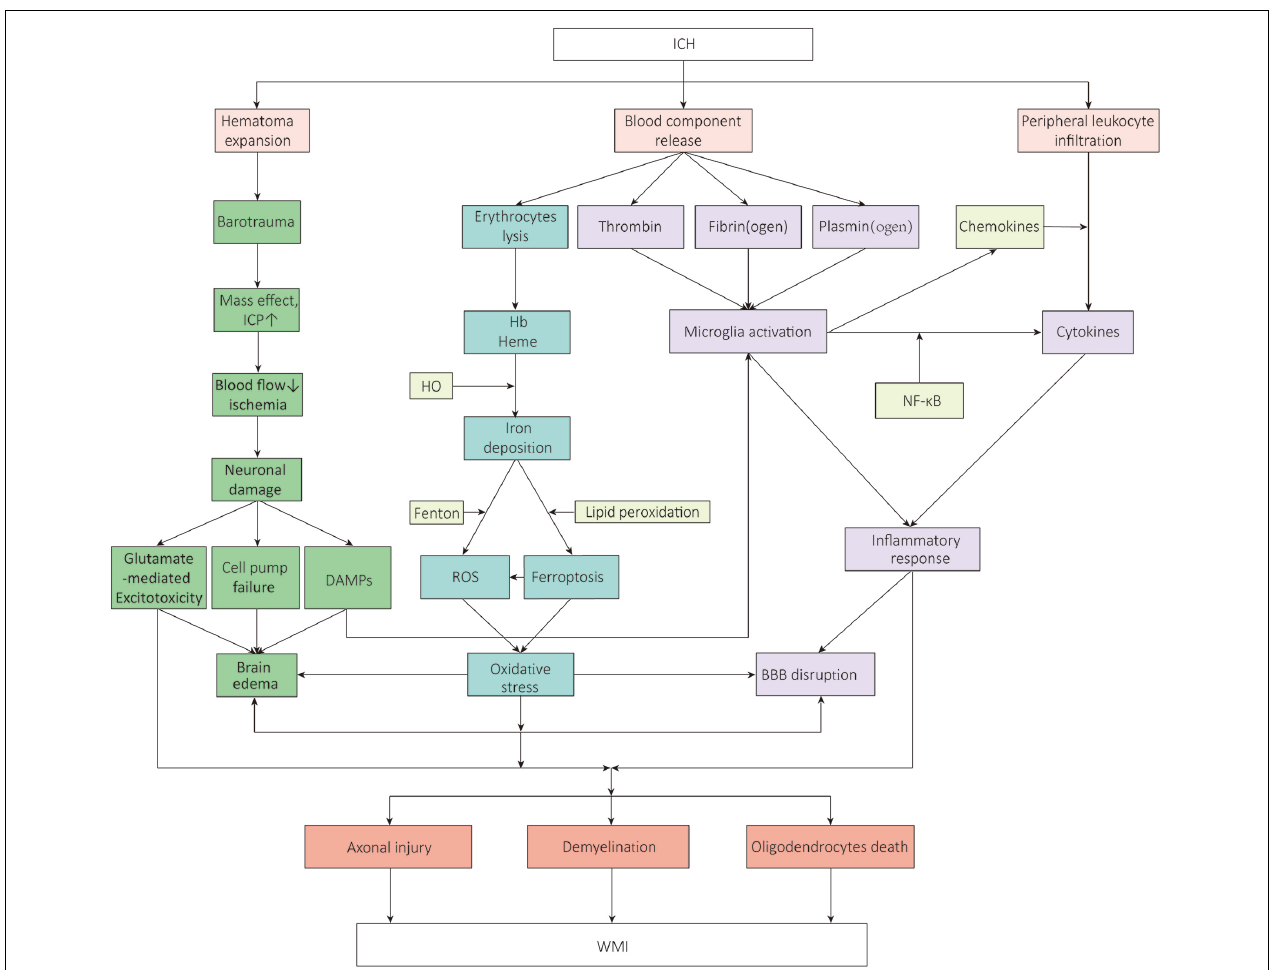
FIGURE 1 | The mechanisms and signal pathways of white matter injury after intracerebral hemorrhage. WMI, white matter injury; ICH, intracerebral hemorrhage; ICP, intracranial pressure; DAMPs, damage-associated molecular pattern molecules; HO, hemeoxygenase; BBB, blood-brain barrier; NF- κ B, nuclear factor- κ B; ROS, reactive oxygen